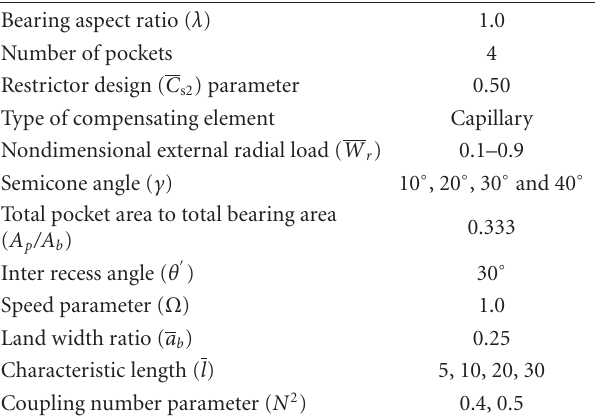
Table 1: Geometric and operating parameters for conical journal bearing system [2, 14, 23, 24,